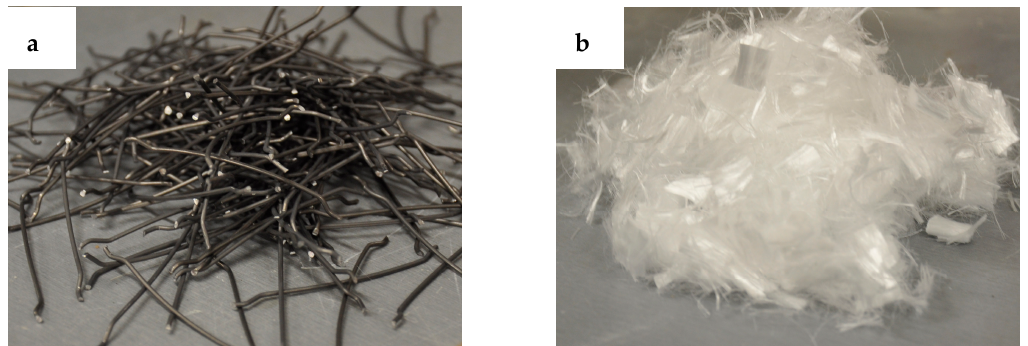
Figure 2. Fabrication of internal steel bars for deep beams DB1, and deep beams with two symmetrically located openings DBO2, DBO3.